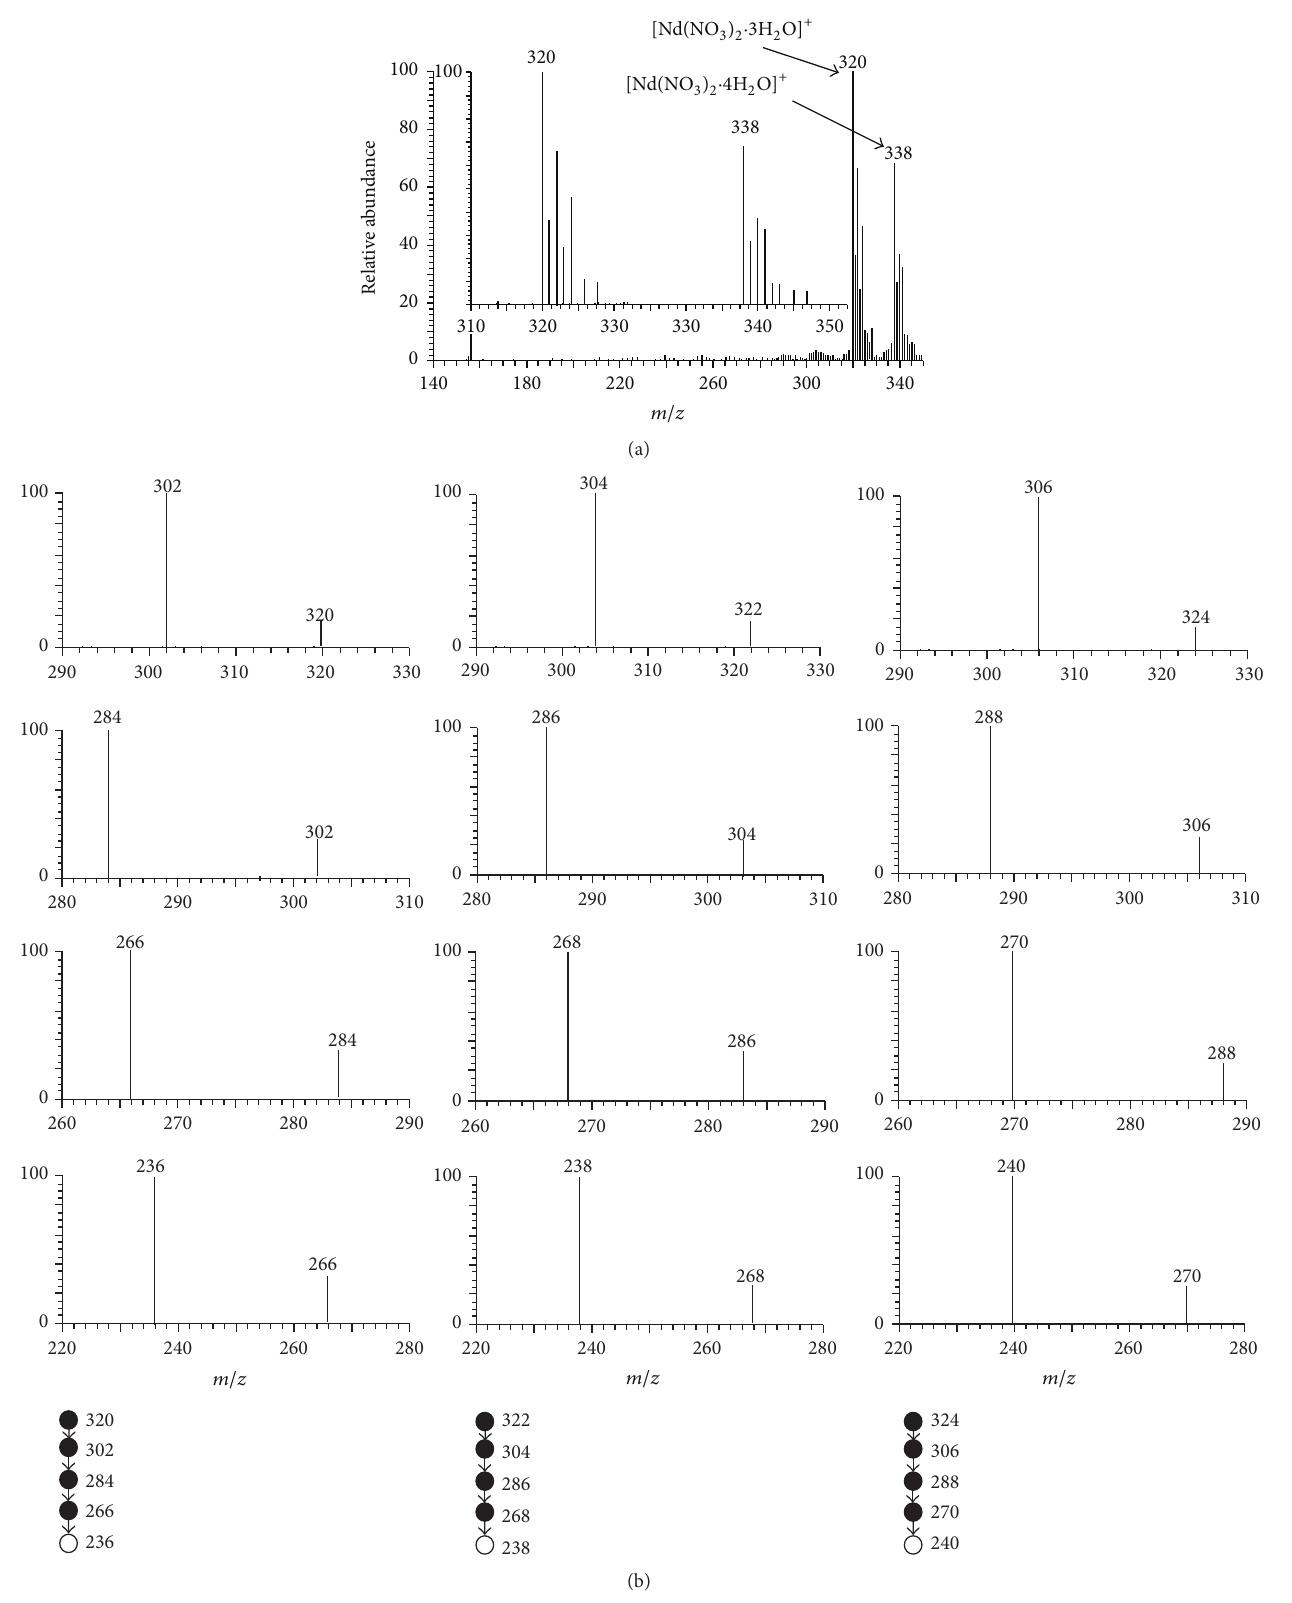
Figure 3: (a) The MPT mass spectrum of neodymium collected on the MPT-LTQ-MS in positive mode. A 10mg/L neodymium standard solution was used. (b) The MS 2 to MS 5 spectra of the ions of 𝑚/𝑧 320, 322, and